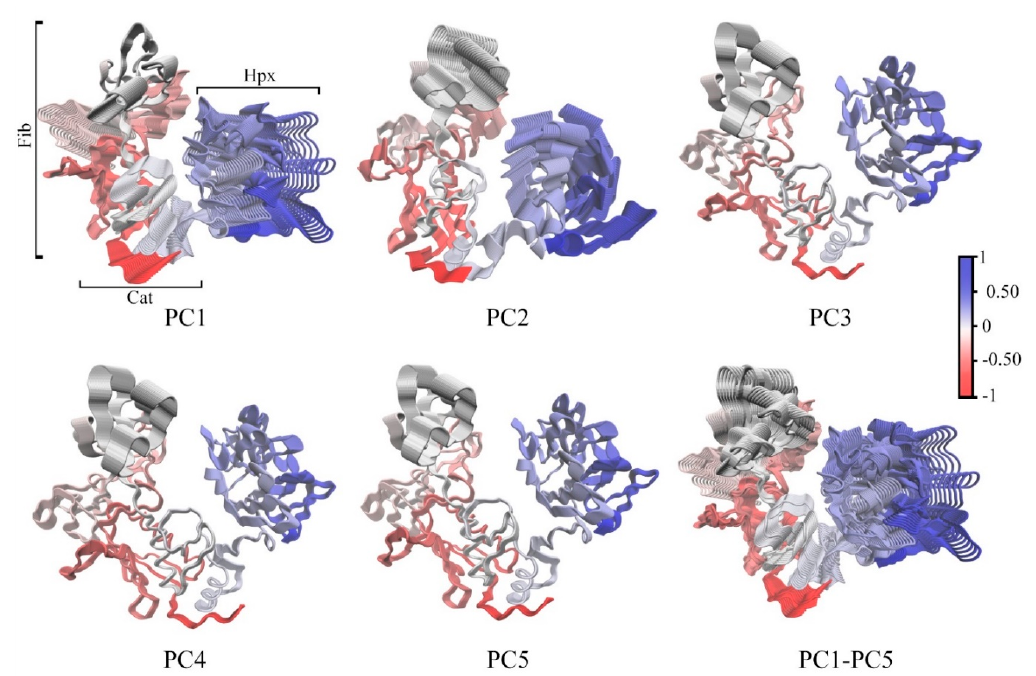
Figure 6. C α -trace of the first five principle components (PC1 through PC5) and an overlay of all principle components PC1-PC5. Correlated domain movements are indicated in blue and anti-correlated are in red. Table 6. Distances of ions to the interacting protein residue atoms identified from the 1CK7 X-ray crystal. Statistically significant protein residue atoms as identified by outlier analysis with the associated per residue interaction energies and binding geometry. 1CK7 identified interactions are